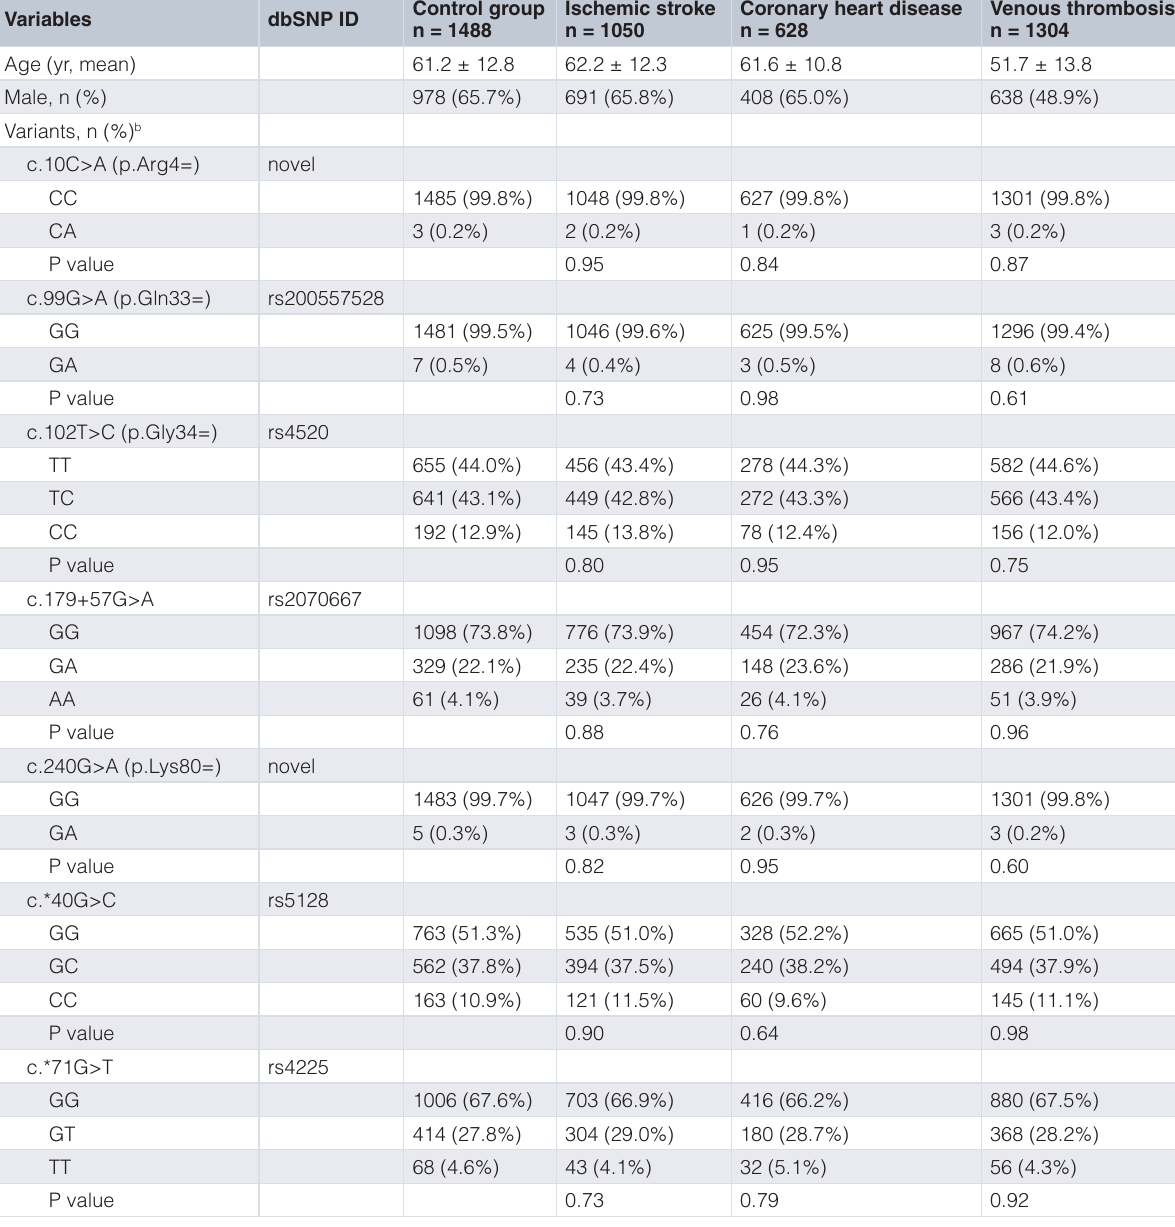
Table 3. APOC3 variants identified in the 4470 Chinese